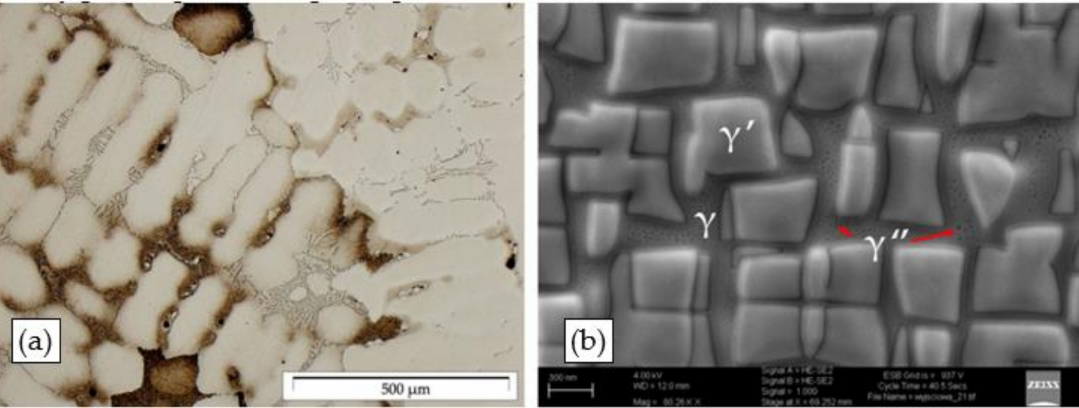
Figure 7. Structure of the Inconel 713C castings: ( a ) dendritic structure with visible eutectic mixtures and carbides (LM); ( b ) γ (cid:48) phase in the γ phase matrix (SEM).